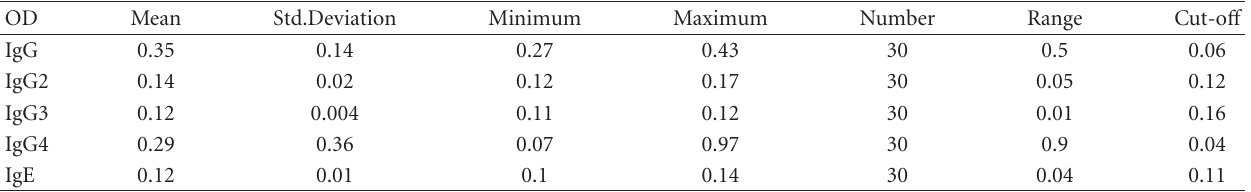
Table 4: The mean OD values of IgG class and subclass responses of 30 naturally infected hyadid patients against mice cystic crude fluid antigens.